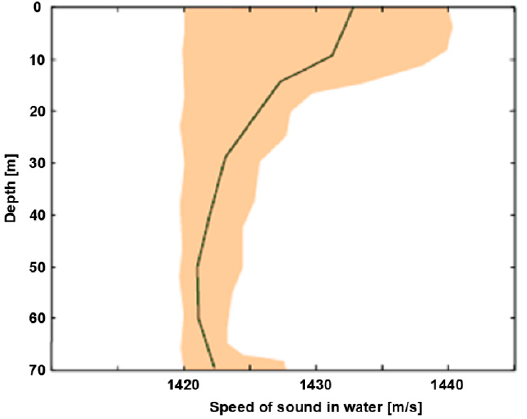
Figure 8. Daily speed of sound changes in summer in the Bay of Gda ń sk. Own study based on [26].